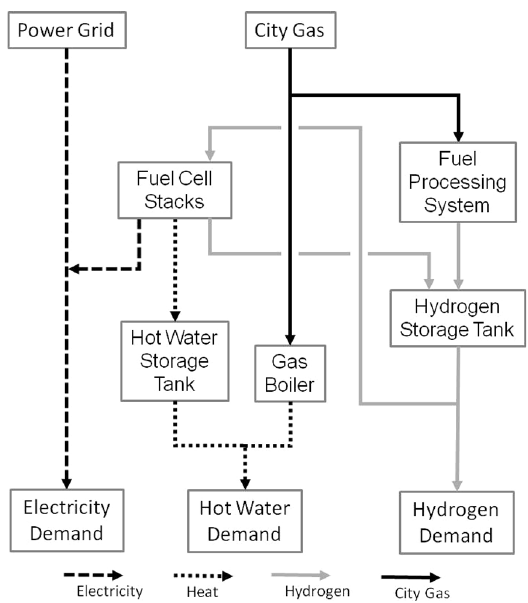
Fig. 4. Schematic diagram of energy fl ows in the proposed PEFC with H 2